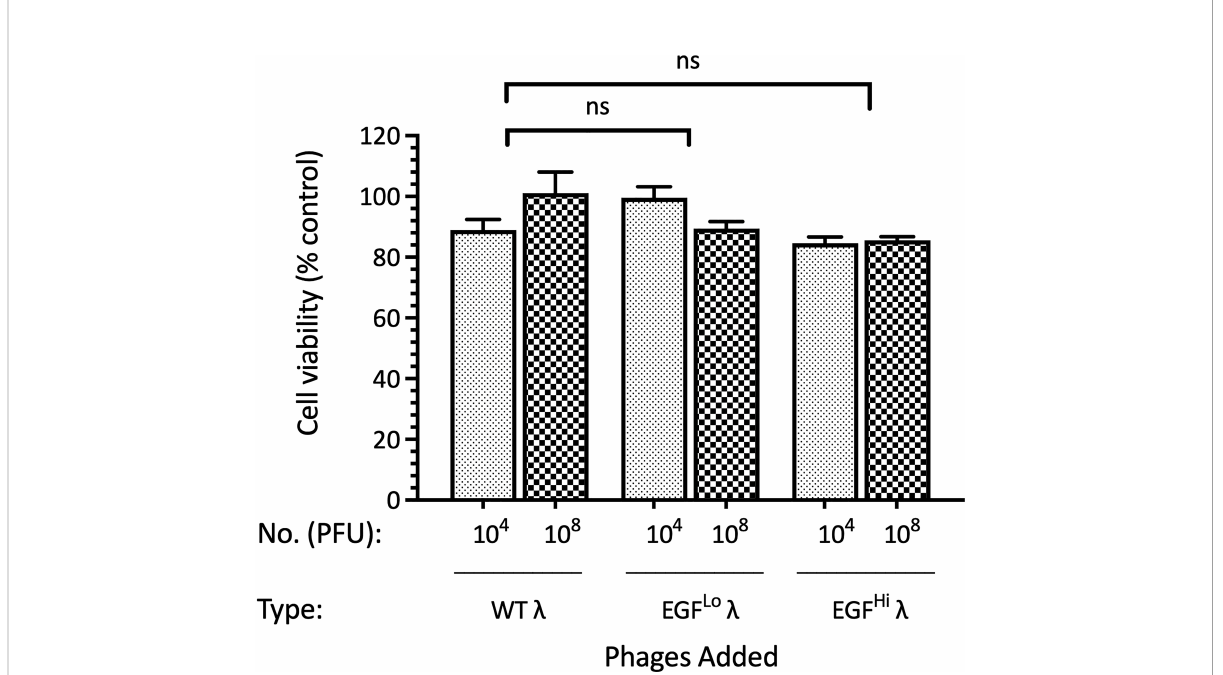
FIGURE 6 WT and EGF l phages are not cytoxic for HT-29 cells grown in monolayer culture. HT-29 cells were established in monolayer for 72 h and then treated with 10 4 or 10 8 PFU of WT, EGF Lo and EGF Hi l phages for a further 24 h. Cell viability was then assayed by the MTT assay and expressed relative to untreated cells. Data are expressed as mean ± SEM of 3 independent experiments, each with 3 culture replicates. Neither comparison with controls or comparison of EGF-displaying l phages with WT (shown) showed a statistically signi fi cant difference. ns, not signi fi